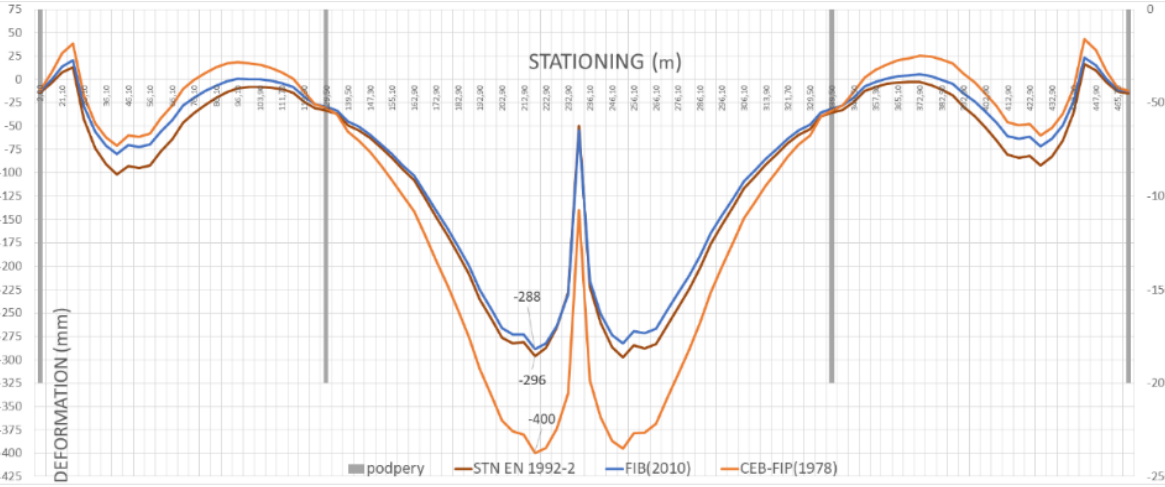
Figure 11. Deflections for di ff erent creep and shrinkage